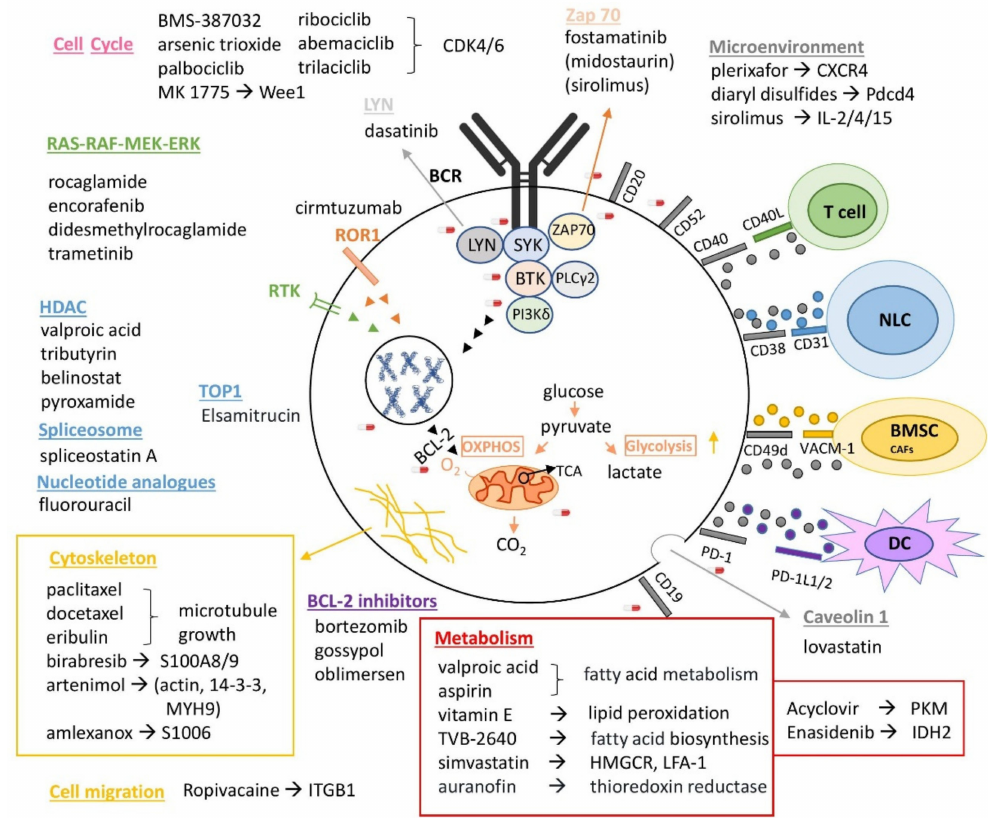
Figure 3. Proposed repurposed drugs in CLL based on both proteomics and drug repurposing data. This figure summa- rizes the best repurposed drugs candidates in CLL and their mechanism of action, based on both proteomics data and drug repurposing studies. Cytoskeleton remodeling and metabolic pathways (mitochondrial biogenesis/bioenergetics, glycolysis/glyconeogenesis, pentose phosphate pathways, ROS detoxification, pyruvate metabolism, TCA cycle, respiratory electron transport metabolism, nucleotide biosynthetic process) highlighted through the proteomics studies should be considered as two novel categories of therapeutic approaches in the fight against